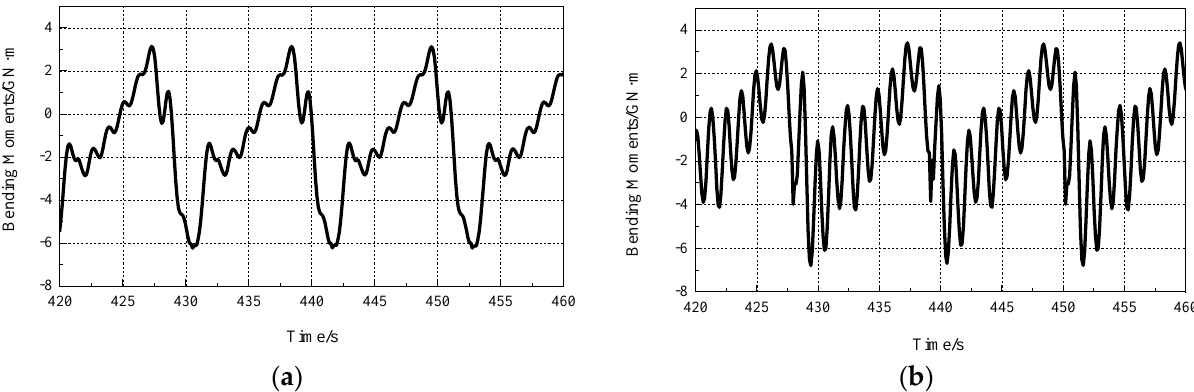
Figure 9. Time histories of bending moments ( U = 10 kn). ( a ) Without slamming effect; ( b ) With slamming effect.